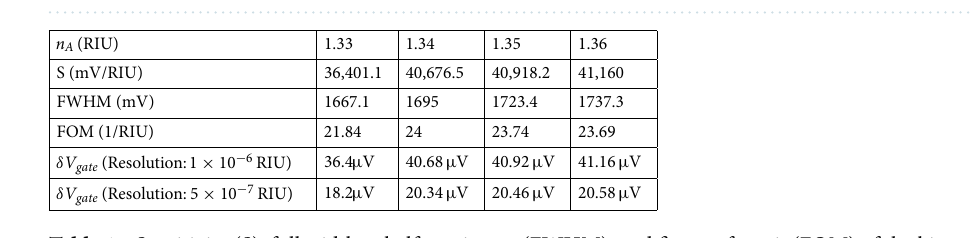
Performance evaluation: RI sensitivity and figure of merit. To evaluate the performance of this sen- sor, we calculate the RI sensitivity and figure of merit. The analyte under test is modeled as a uniform dielectric layer with refractive index n A and thickness of 8 nm. Here, four samples with n A = 1.33 , n A = 1.34 , n A = 1.35 , and n A = 1.36 are considered. Table 1 shows the performance parameters of the biosensor. The first row is RI of analyte under test. The second row lists the sensitivities each of which evaluated in the vicinity of respective RI with an increment δ n A = 0.001 . The third row shows the full width at half maximum (FWHM) of the SPR curve against gate voltage for each case. Moreover, FOM (defined by FOM=S/FWHM) of each sample is listed